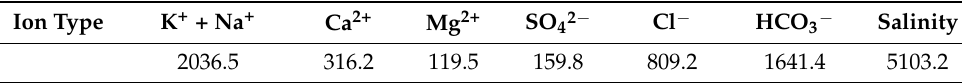
Table 5. Composition of simulated formation water